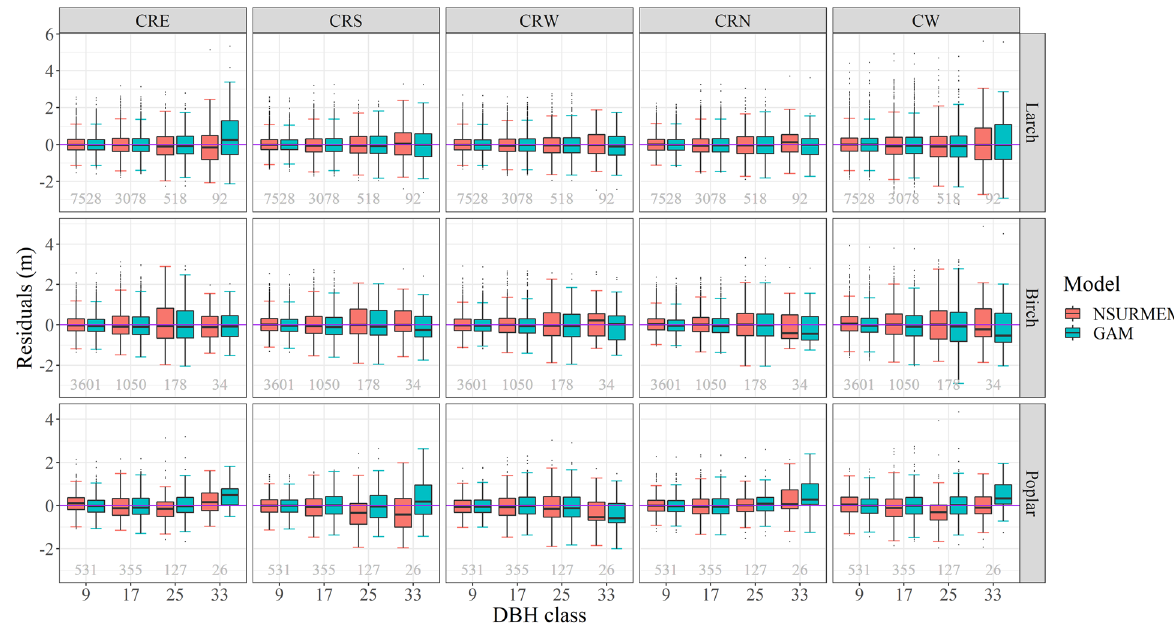
Fig. 8 Boxplots of residuals in different DBH classes of NSURMEM and GAM systems for larch, birch, and poplar. The grey numbers below each subplot indicate the observations of each DBH class for each tree